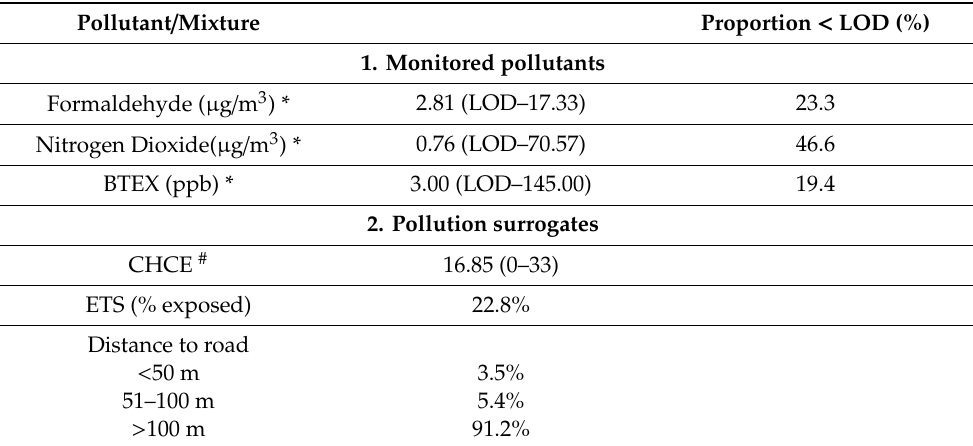
Table 2. Concentrations and proportions of measured pollutants and pollution